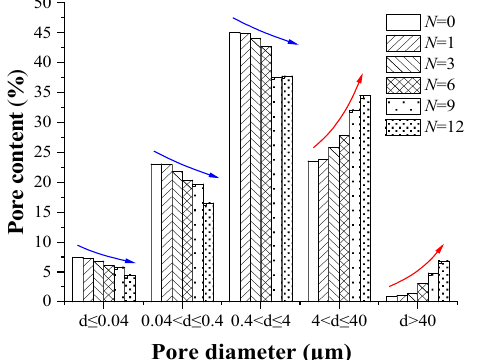
Figure 10. Effect of freeze–thaw cycles on pore diameter.